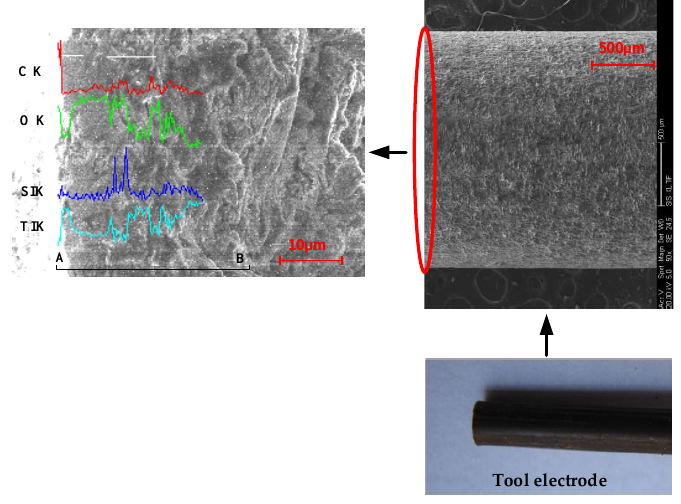
Figure 8. Sketch map of line scanning at A – B stage.